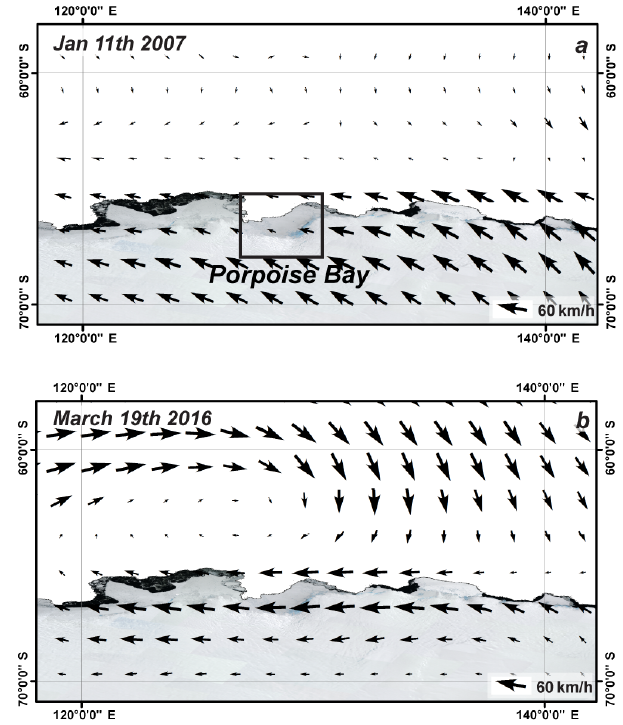
Figure 11. ERA-Interim derived wind fields for the estimated dates of sea ice break-up. (a) 11 January 2007 and (b) 19 March